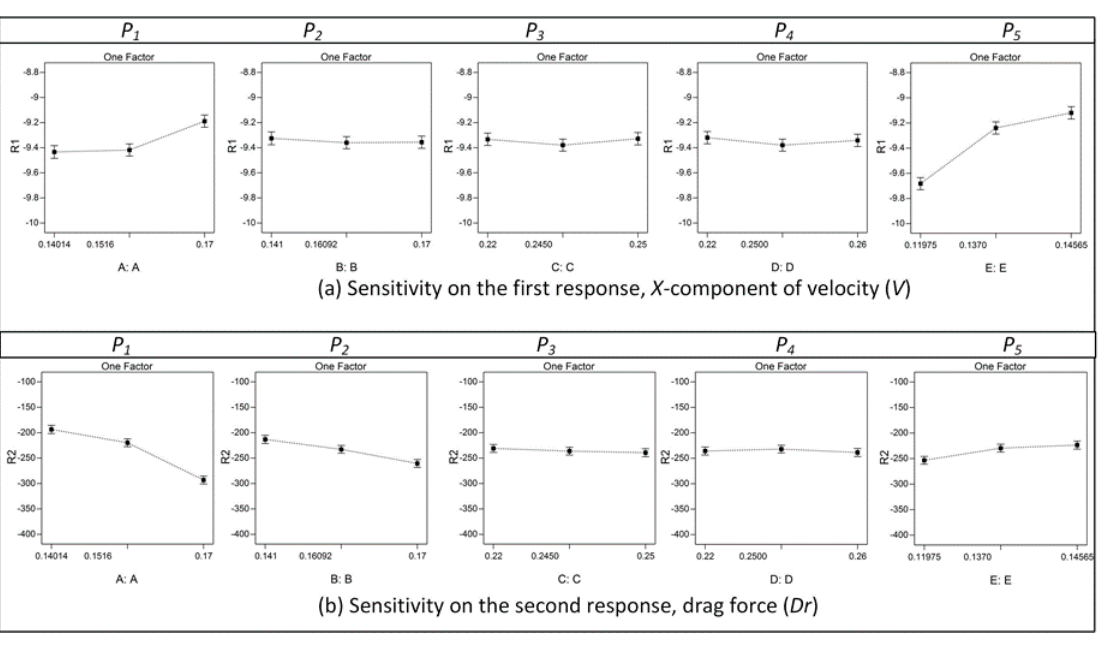
Figure 11. Sensitivity test results of parameters: ( a ) sensitivity on the first objective parameter; ( b ) sensitivity on the second objective parameter.